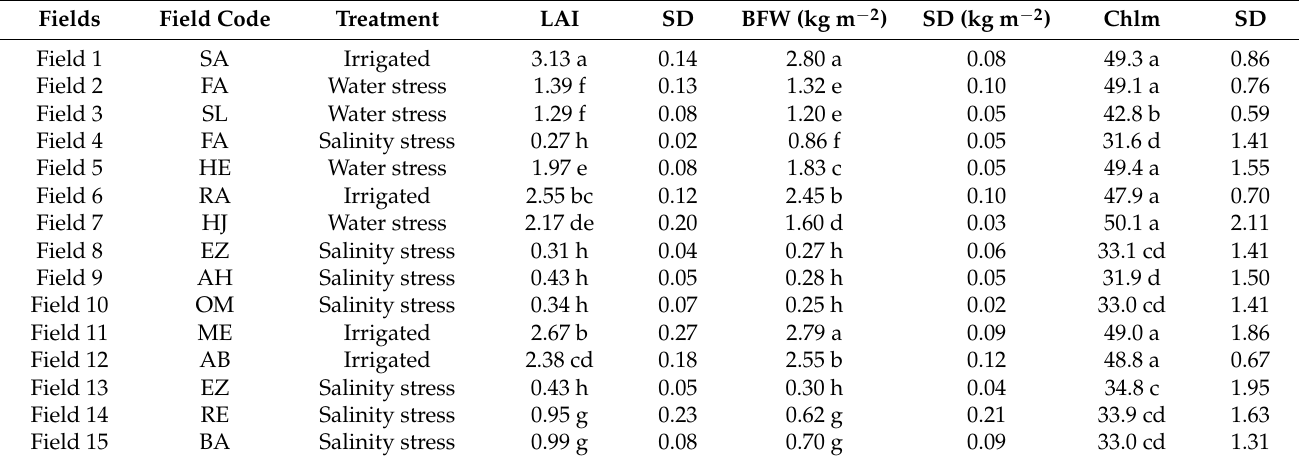
Table 3. Mean and standard deviation (SD) of leaf area index (LAI), biomass fresh weight (BFW) and chlorophyll meter (Chlm) of